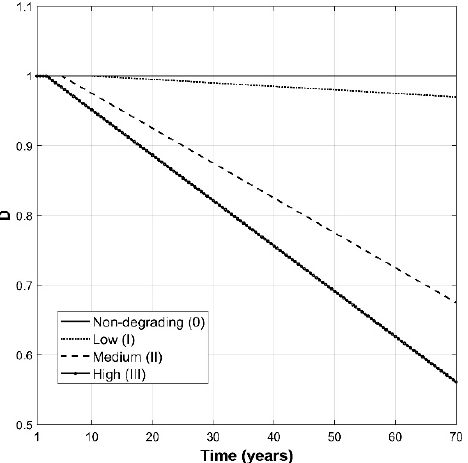
Figure 5. Investigated degradation conditions for steel reinforcement.